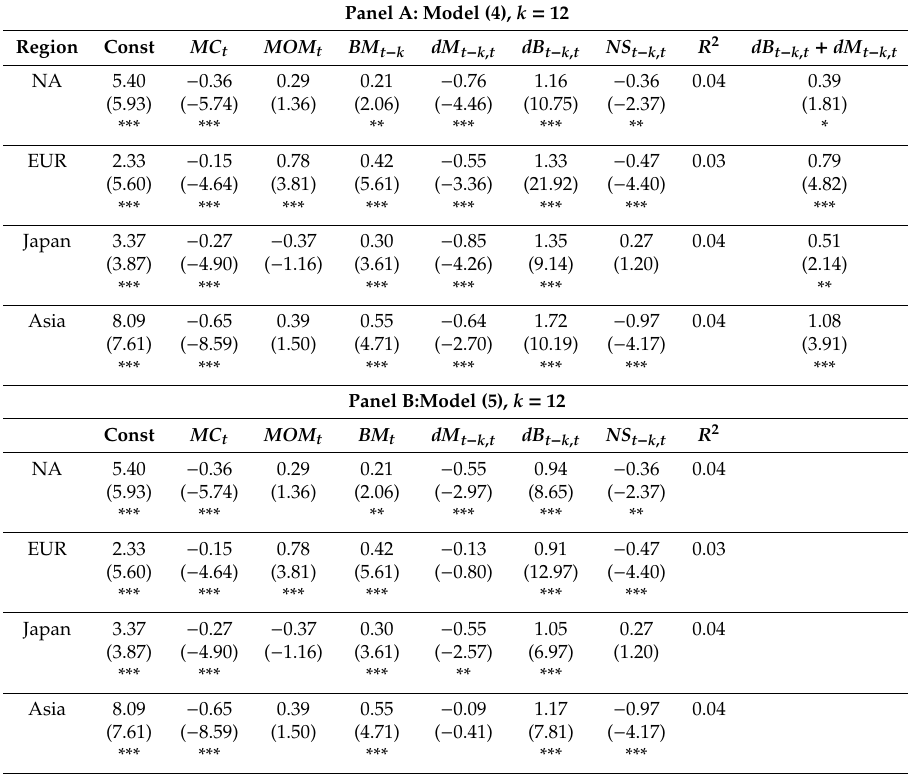
Table 5. Models (4) and (5) Regression Estimates—Small Stocks, 1991–2016. Results presented in Panel A are based on the same analysis of Model (4) as described in Table 2, and results presented in Panel B are based on the same analysis of Model (5) as described in Table 3. Regressions here use the set of small stocks defined as the set of stocks with the smallest market capitalization that in aggregate comprise 10% of the total market cap for each region. *** / ** / * indicates significance at the 1, 5, and 10% level,